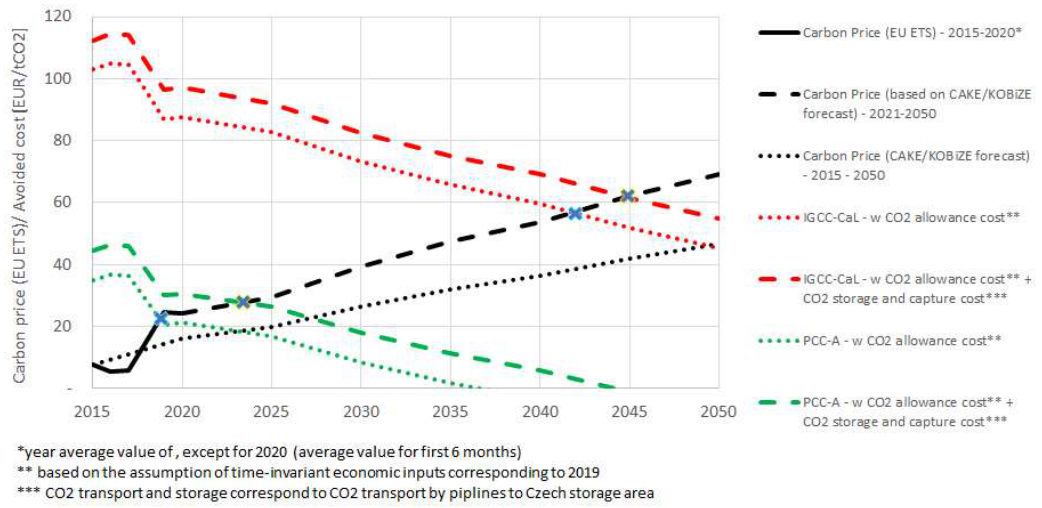
Figure 5. The cost-effectiveness of selected CCT integration into power plants.